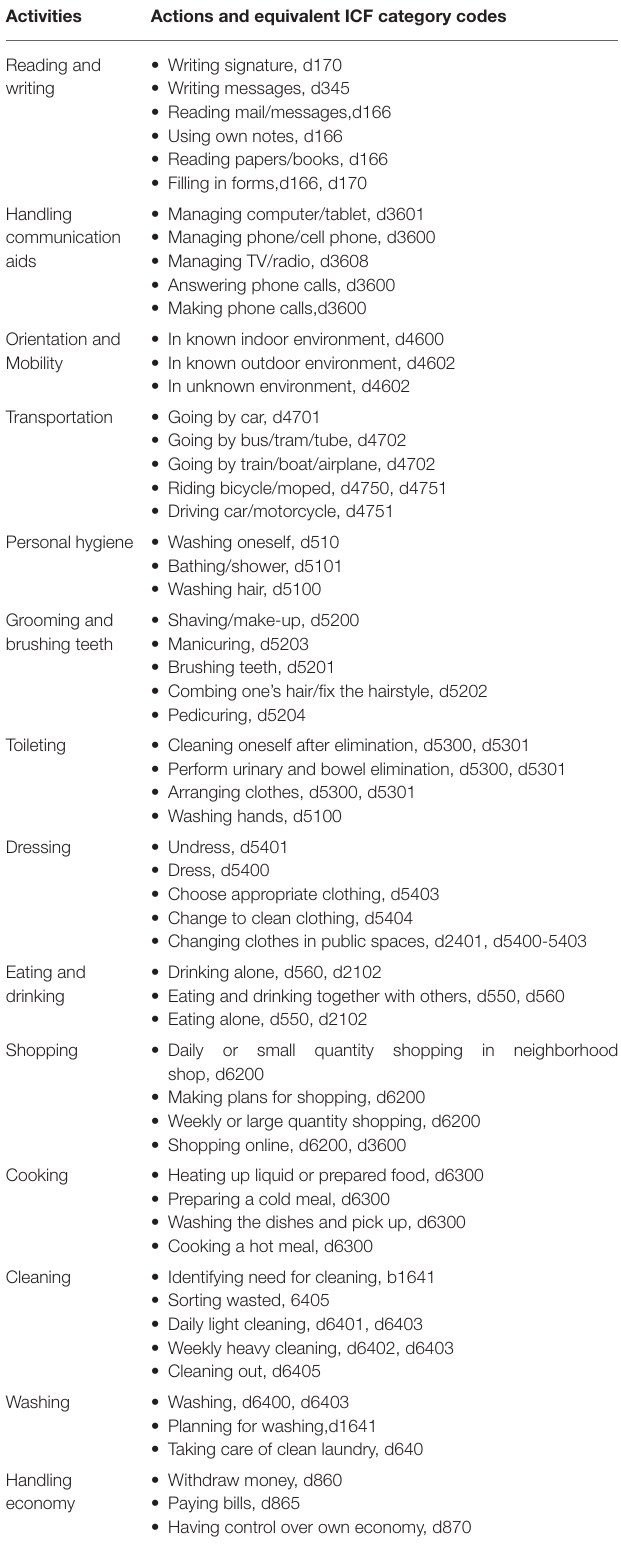
TABLE 1 | Actions, activities and equivalent ICF categories in the